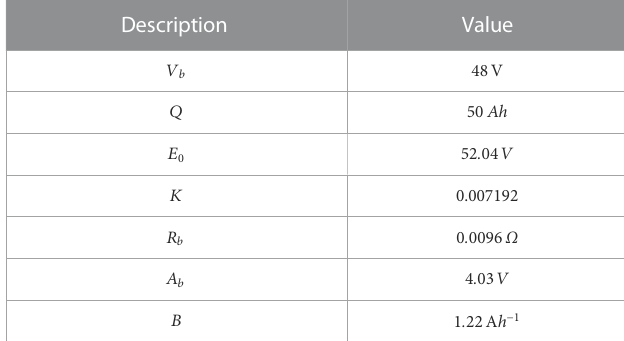
FIGURE 4 Electrical model of li-ion battery.